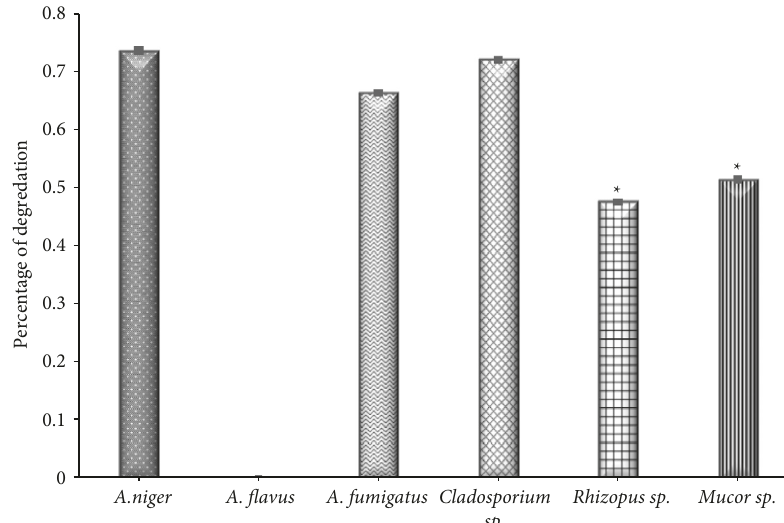
Figure 4: The activity of cellulase of endophytic fungi isolated from Ziziphus spin a leaves on solid medium. ∗ Significant difference with ( A. Niger , A. flavus, (A) fumigatus, and Cladosparium sp. ), at P < 0 .